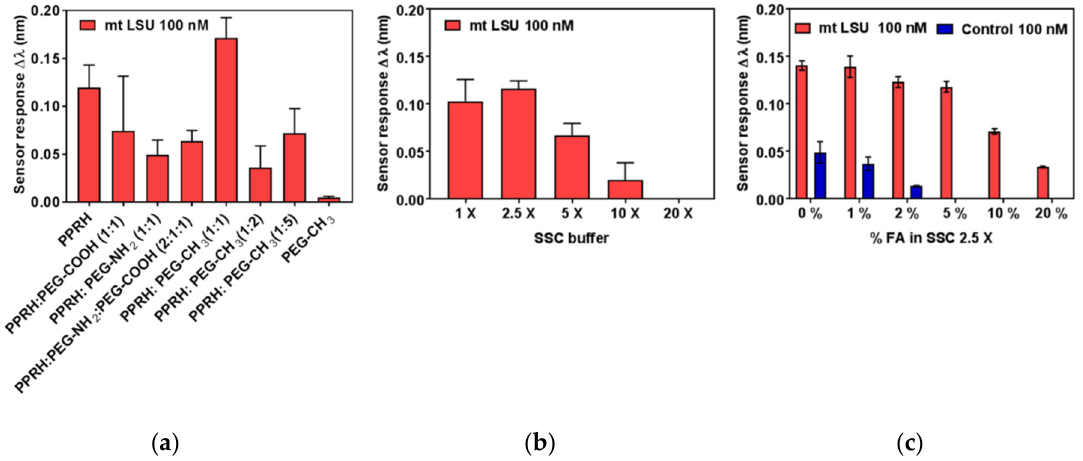
Figure D1. Optimization of the methodology for selective detection of the mtLSU rRNA gene. ( a ) Detection signals obtained by employing different surface SAMs in the immobilization of PPRH probes. ( b ) Effect of changes in the ionic strength of the hybridization buffer on the mtLSU rRNA recognition using PPRH probes. ( c ) Formamide effect in the cross-hybridization response of PPRH probes.